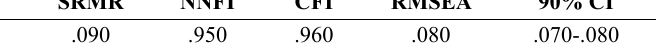
Table 2 Fit indices of the measurement models of PLOCQp (including existing versions)